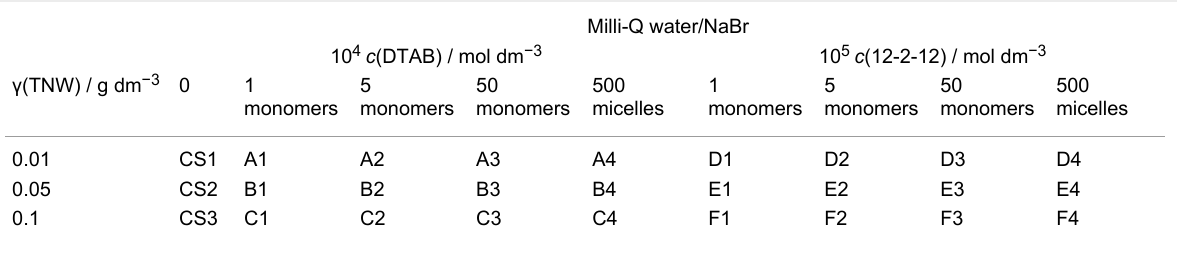
Table 3: Composition of the investigated TNWs and TNW/surfactant systems and used notation. Surfactant aggregation states are also indicated. The TNW/surfactant systems were prepared in Milli-Q water or in 1 × 10 − 3 mol dm − 3 NaBr. In the text, the systems with NaBr are labeled with asterisk, e.g.,